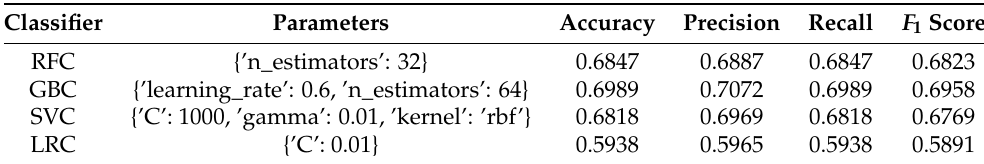
Table 7. Performance scores of the depression classifier using only activity tracking features on the training set.